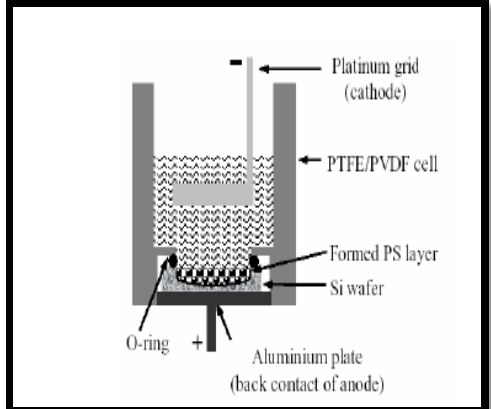
Fig.1: Schematic digram of expermental ste-up for preparing n-PS layer vertical